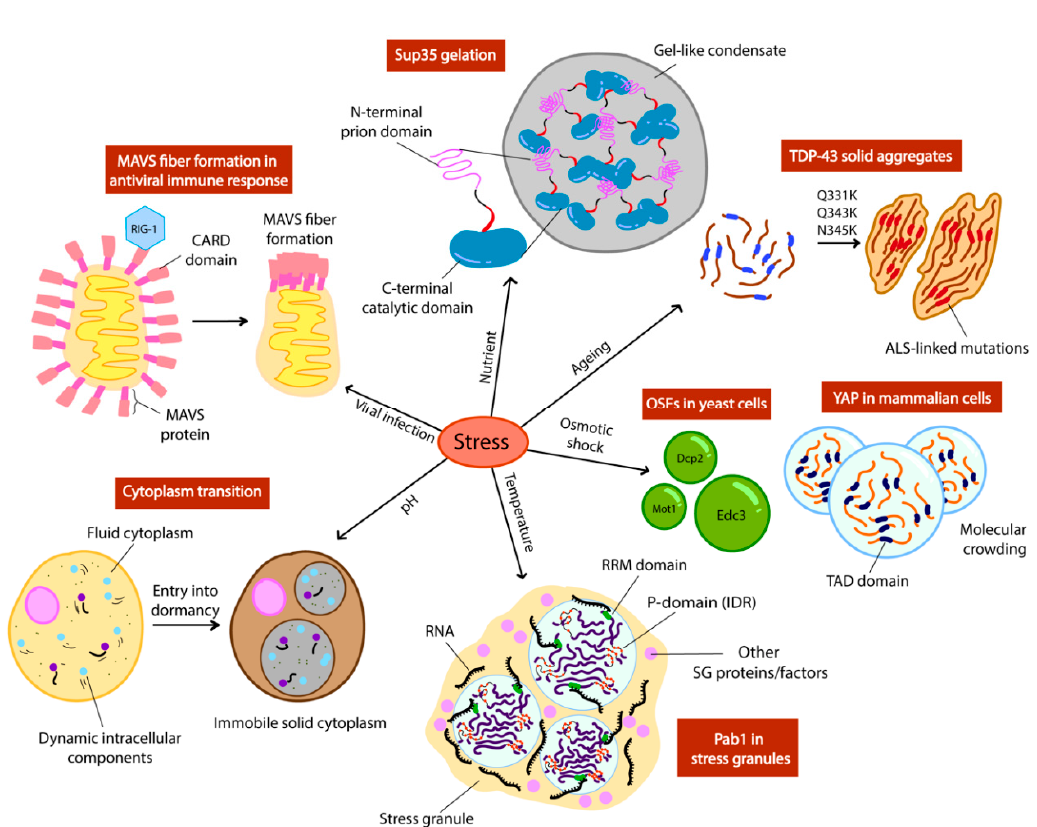
Figure 2. Different stress signals trigger phase separation of intracellular components in yeast (OSFs, Pab1, cytoplasm, Sup35) and mammalian cells (MAVS, TDP-43, YAP). Schemes adapted from [12,14,71].